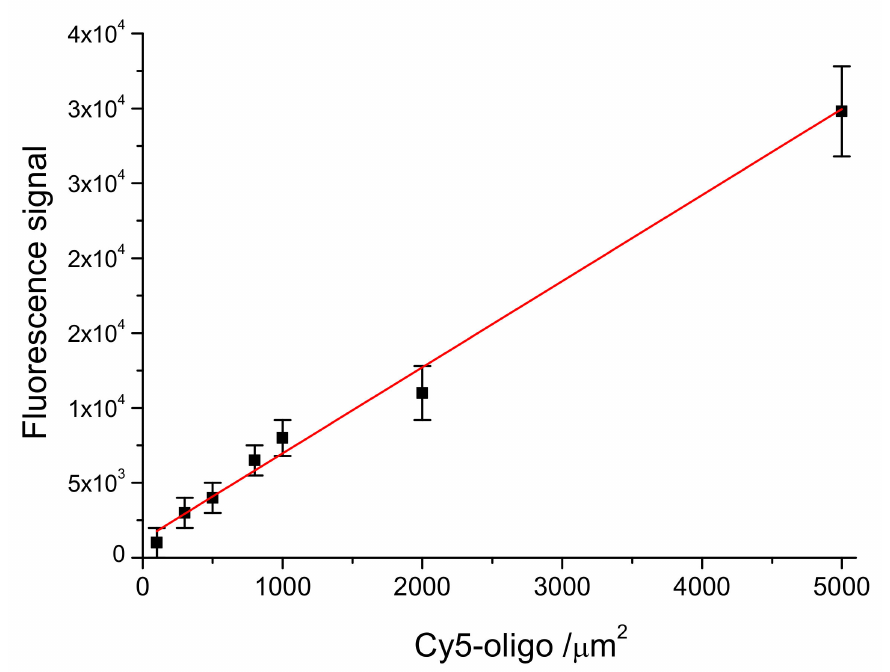
Figure 4. Linear correlation between the probe density (Cy5-oligo/ µ m 2 ) versus the fluorescence signal intensity (Y = 1220 + 5.8X; R 2 =